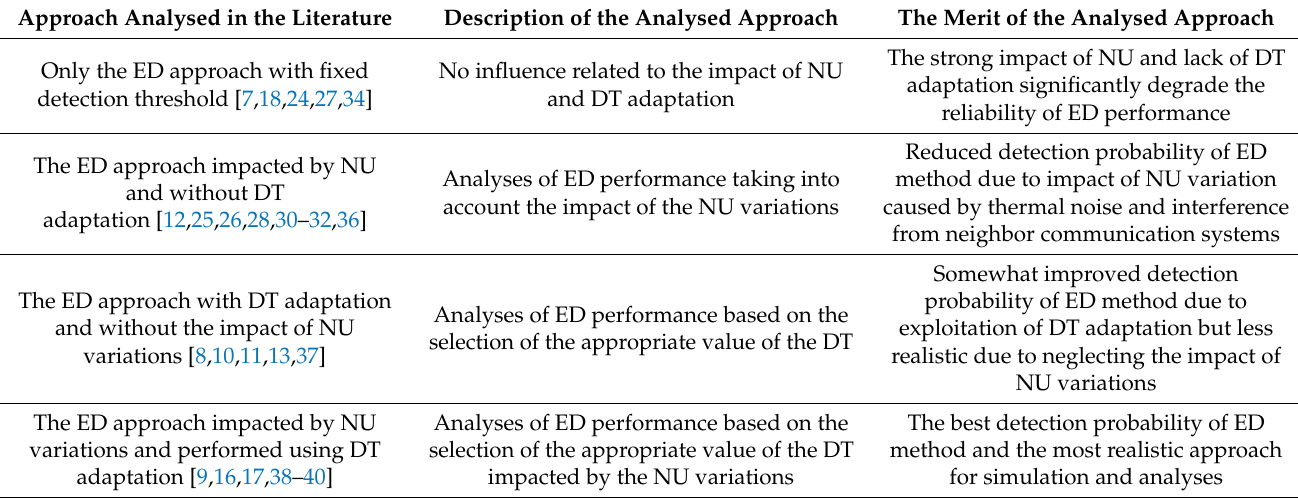
Table 1. Overview of ED methods analysed in the literature and their corresponding